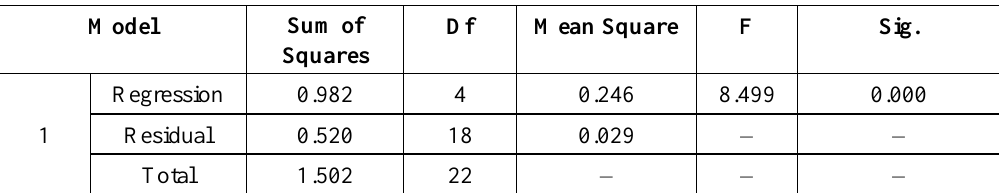
Table 2. ANOVA test of results (Author’s computation, 2019) Model Sum of Df Mean Squares